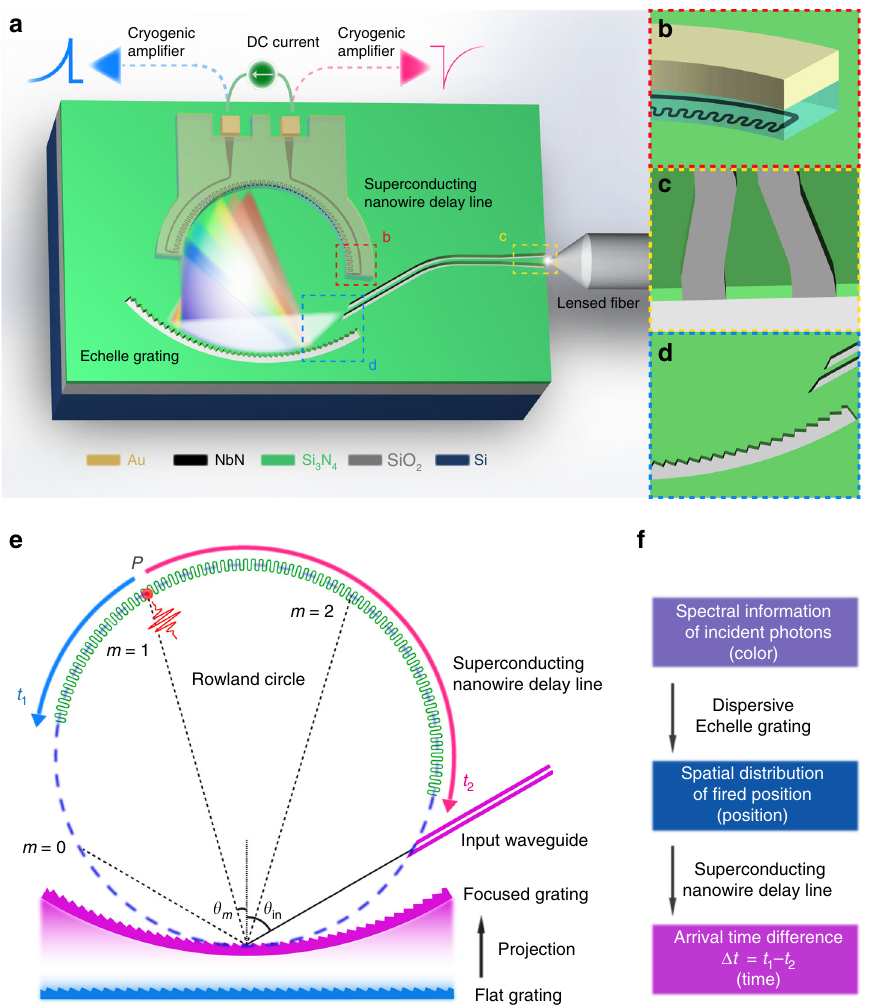
Fig. 1 Device architecture and operation principle. a – d Three-dimensional sketch of the device. The on-chip focusing echelle grating operates as wavelength-discriminating microphotonic component while the superconducting nanowire functions simultaneously as a single-photon detector and a slow microwave delay line to continuously map the dispersed photons. The nanowire is capped with AlO x as high- k dielectric material and Al as top metal ground to form a slow microwave transmission line. e Schematic illustration of the Rowland mounting. The input waveguide and the superconducting nanowire are mounted on the Rowland circle, which internally tangents with the focusing grating line. The focusing grating is projected from a fl at grating with the radius of the curvature equal to the diameter of the Rowland circle. f Schematic representation of the signal transduction pathway and the